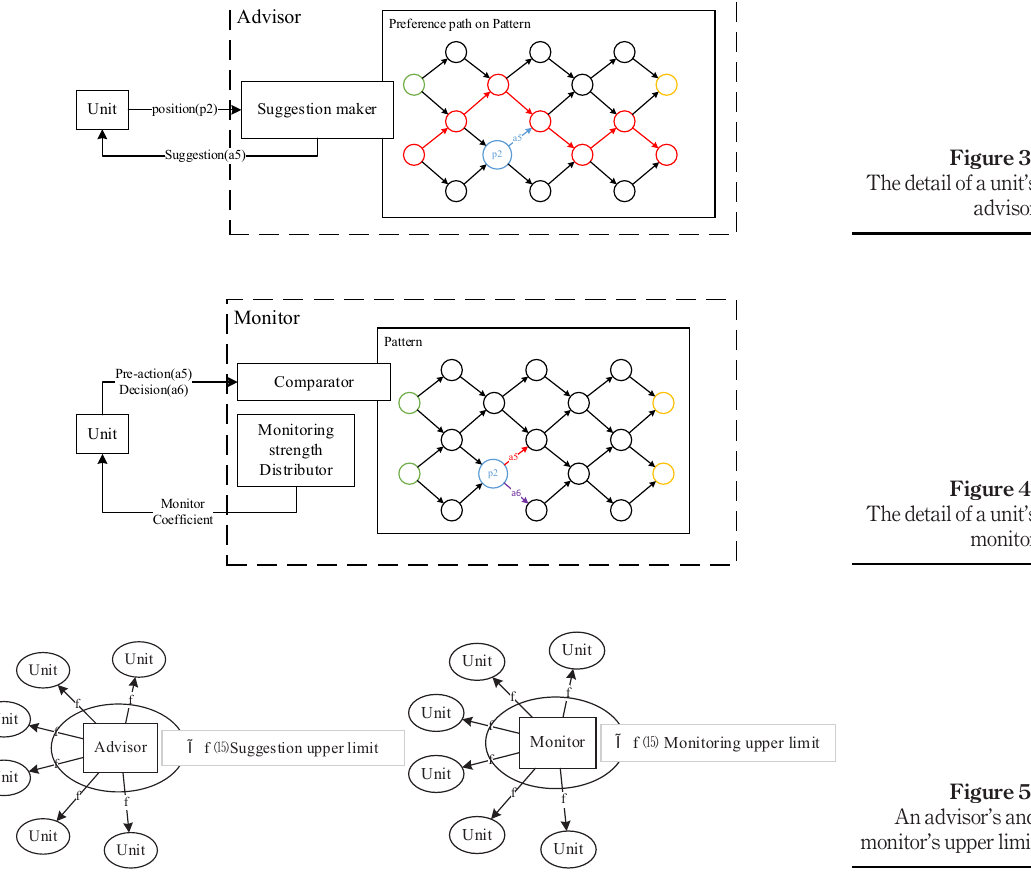
Figure 5. An advisor ’ s and